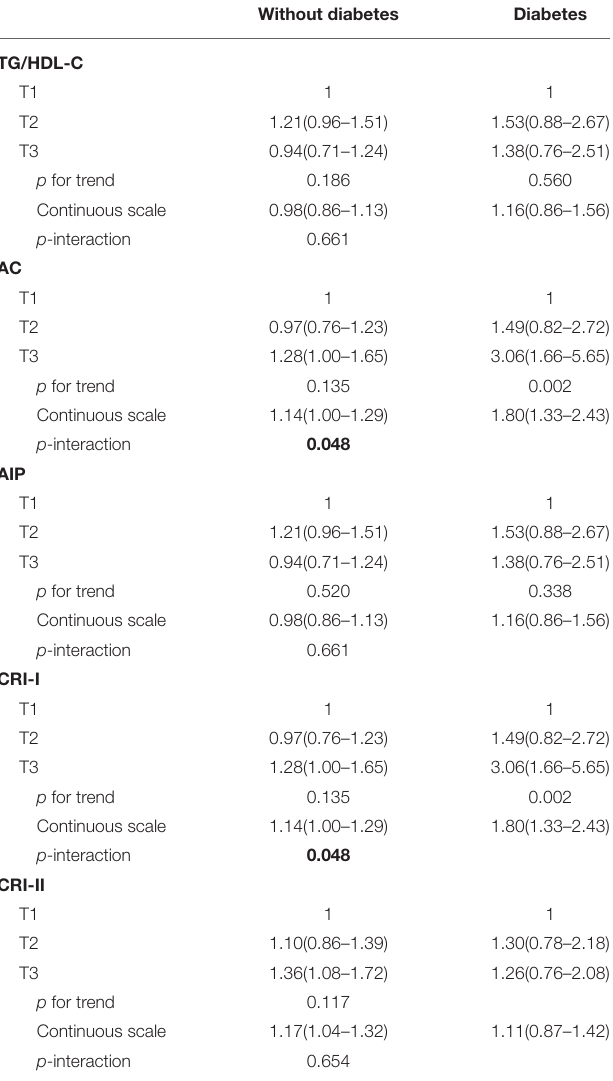
TABLE 2 | Adjusted ORs with 95% CI of aICAS according to non-traditional lipid parameters, stratified by